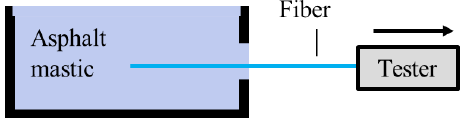
Figure 1. Schematic of pull-out test.